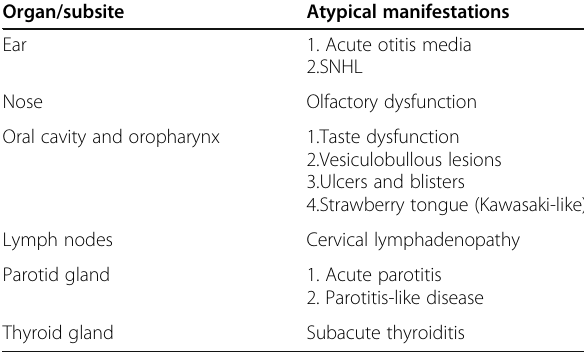
Table 1 Atypical manifestation of COVID-19 in otolaryngology